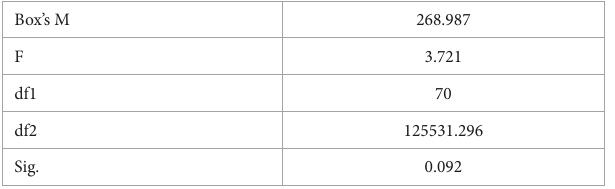
TABLE 6 Box’s test for equality of covariance matrices. TABLE 7 Levene’s test for equality of error variances a